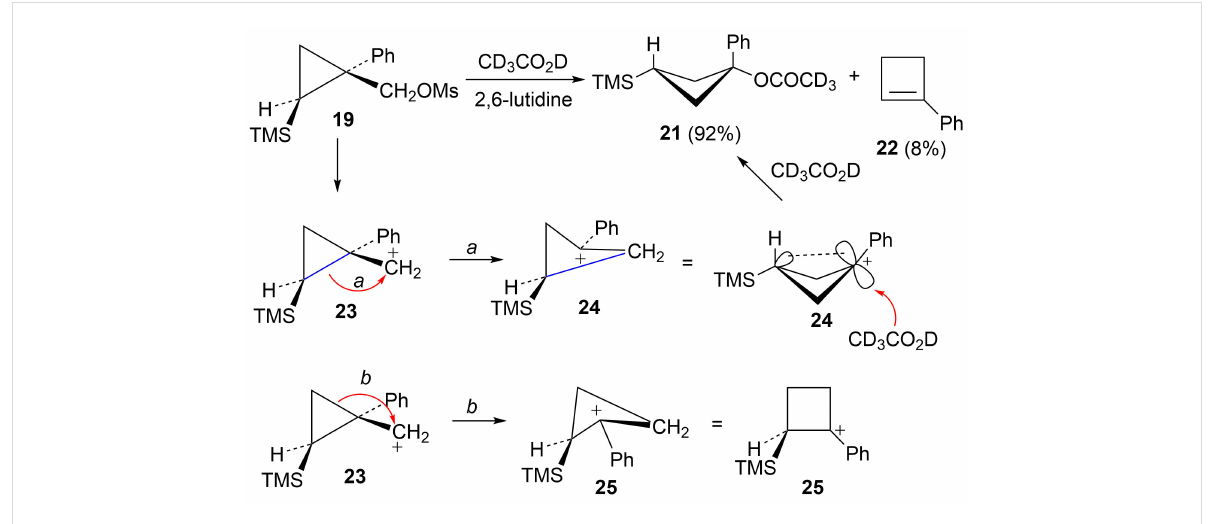
Scheme 5: Reaction of mesylate 19 in CD 3 CO 2 D.